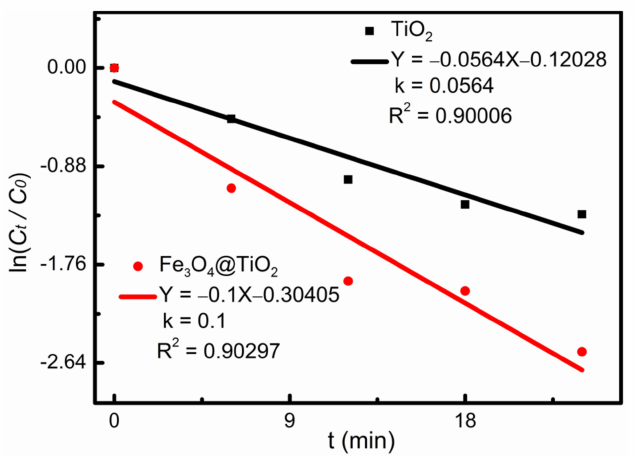
Figure 8. Linear fitting of first-order kinetics of photocatalytic degradation of AR73.